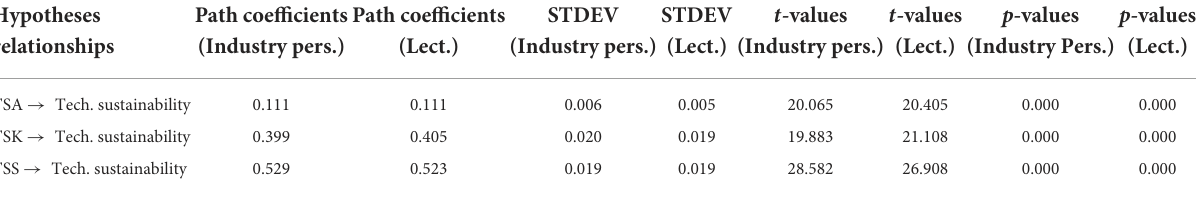
TABLE 7 Multi-group analysis—bootstrapping results for groups 1 and 2.